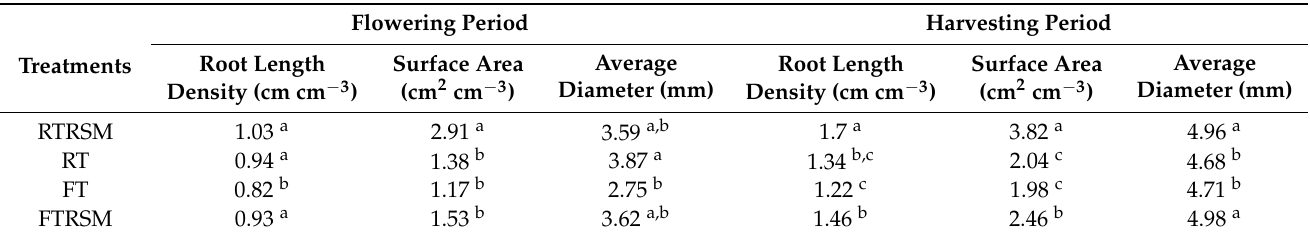
Table 2. The root morphology of faba bean under different treatments at different